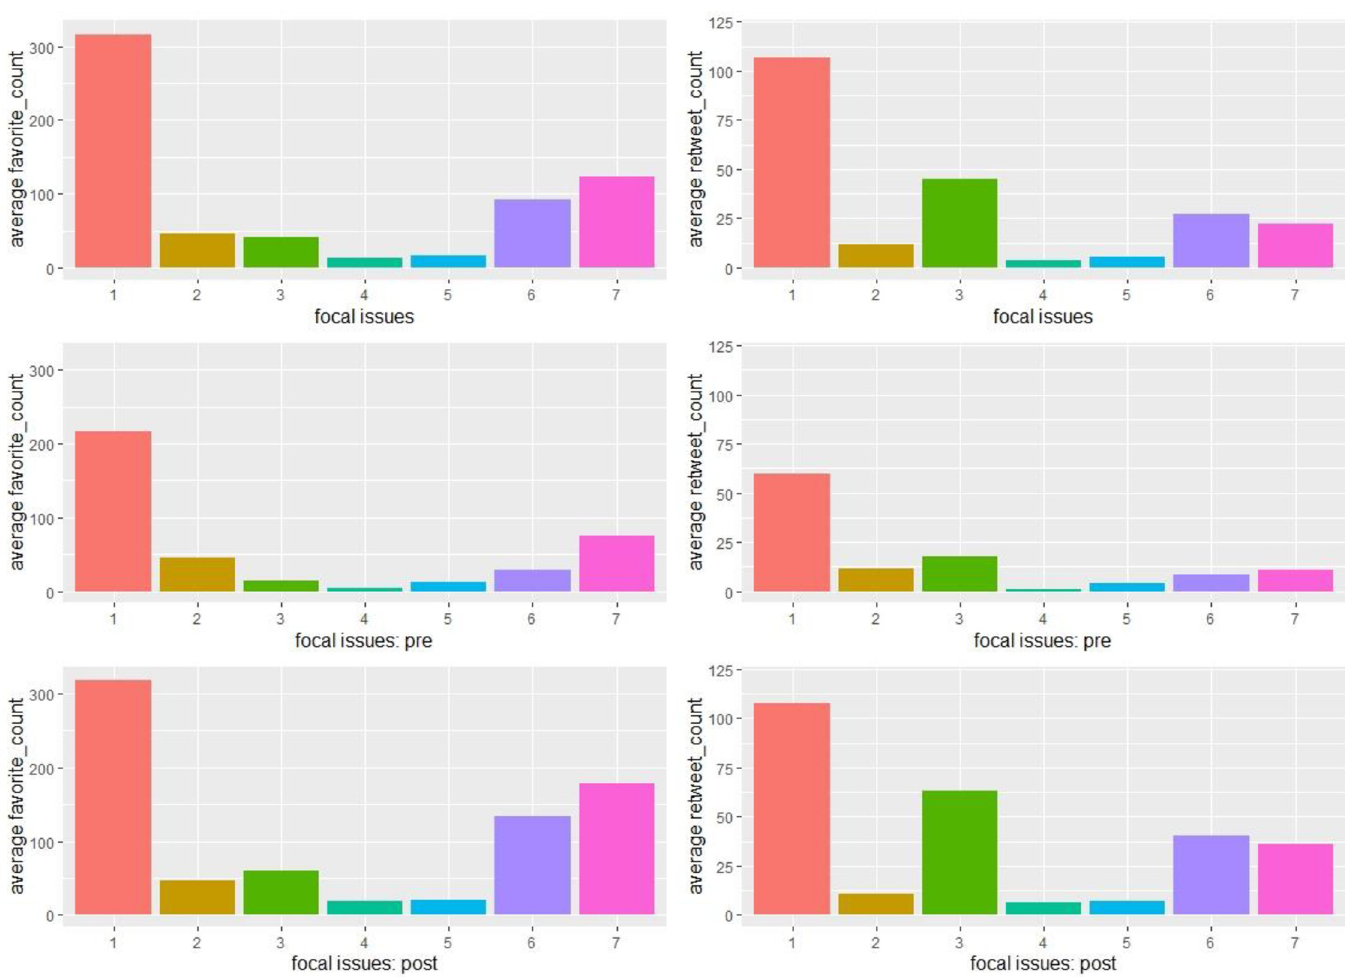
Fig 8. Public reactions by focal issues of the tweets posted by the 115 major police departments in the U.S. before and after the killing of George Floyd on May 25 th , 2020. Focal issues: (1) civil unrest related; (2) COVID-19 related; (3) police gathering of information; (4) police communication of administrative and mundane information; (5) police communication of traffic information; (6) police communication of case updates; and (7) community engagement and outreach.